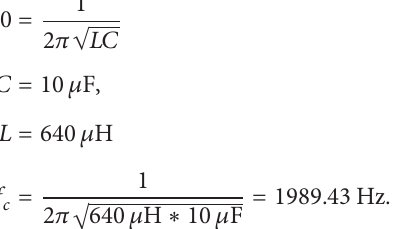
Figure 10: The line-to-line voltage waveform (with LCL